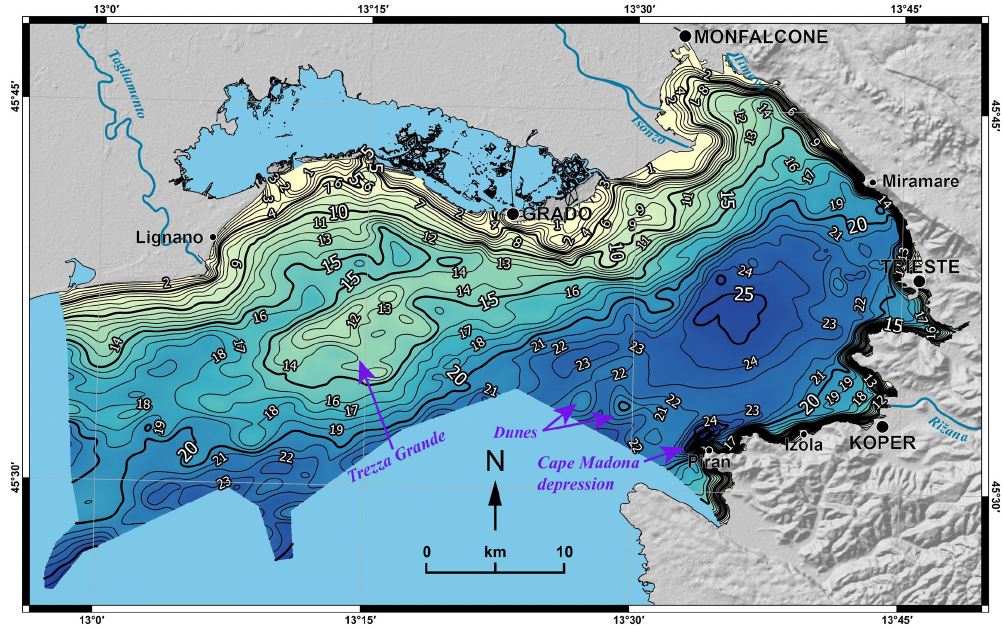
Figure 6. Map of the bathymetry of the Gulf of Trieste (in metres) with prominent morphological features indicated with purple